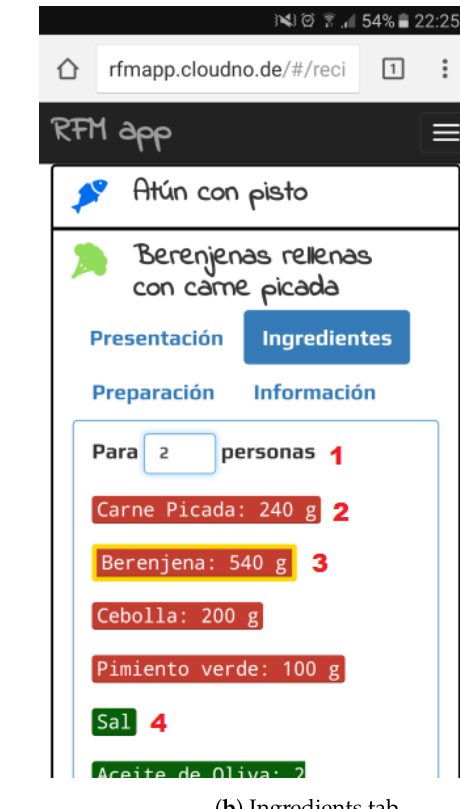
Figure 4. The user can access many options from the main menu.